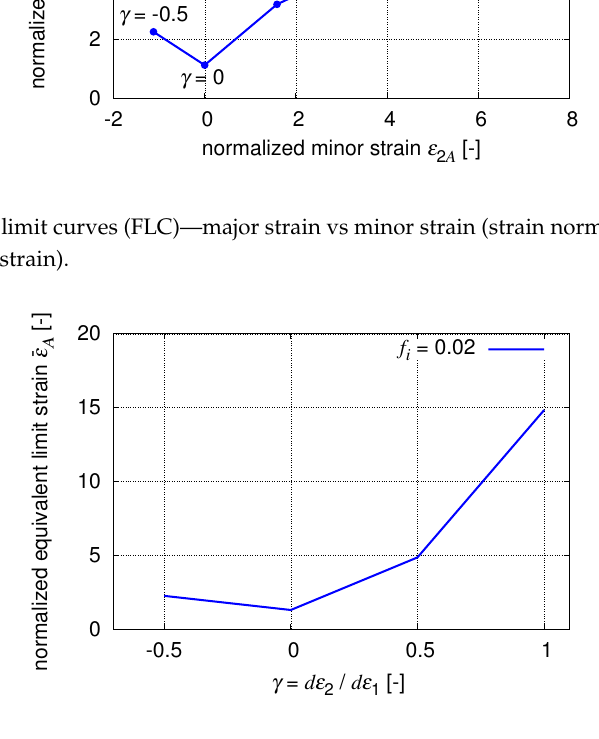
Figure 7. FLC—normalized equivalent limit strain for different loading paths (strain normalized with respect to the mean uniform